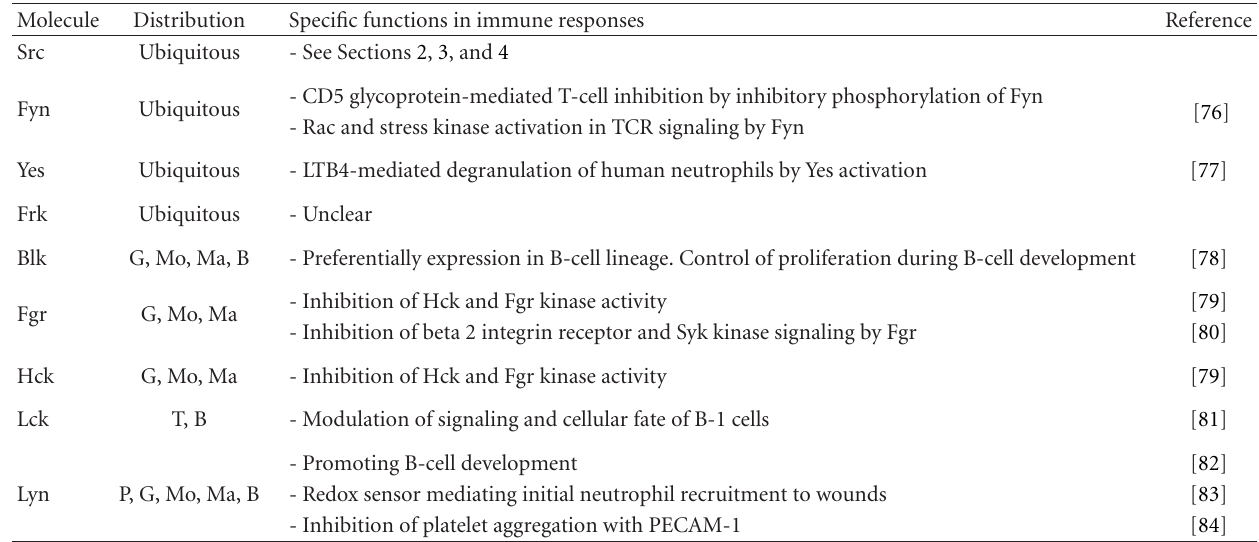
Table 1: Src family kinases and their functions in immune responses.